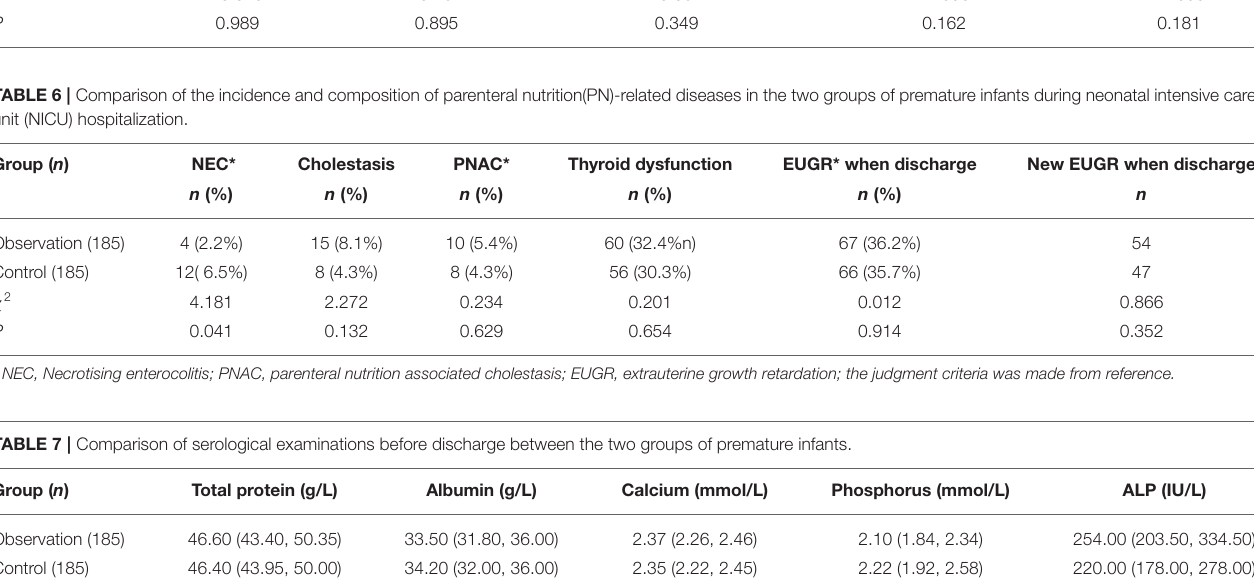
TABLE 5 | Comparison of duration of enteral nutrition (EN), hospital stay, and defecation between the two groups of premature infants. Group ( n )